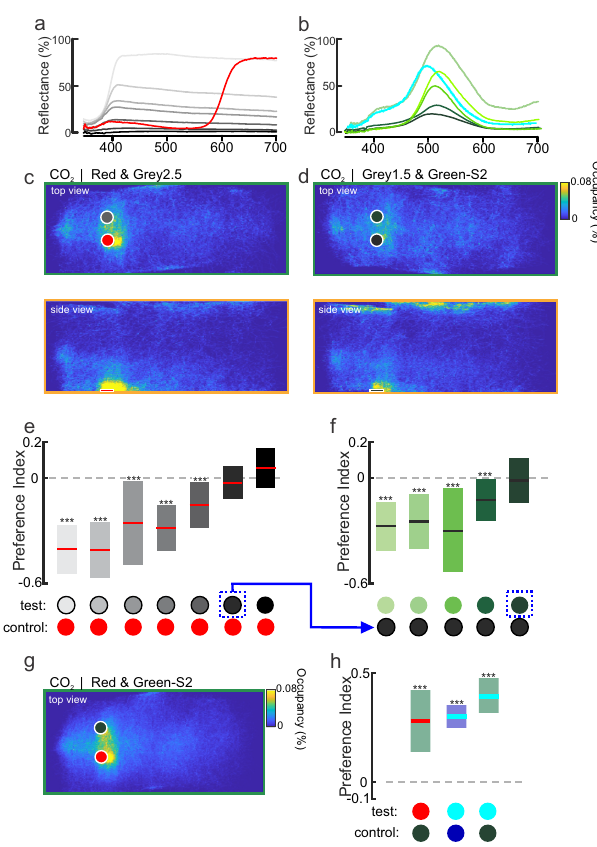
Fig. 6 The role of dominant wavelength vs. contrast in mosquito visual attraction. a Spectral re fl ectance of 660 nm (R-Hue), black, and gray objects used in the experiments: Gray 9.5, 6.5, 4.5, 4.0, 2.5, and 1.5, with Weber contrast values of − 0.17, − 0.30, − 0.05, − 0.10, − 0.20, − 0.24, − 0.27, and − 0.28, respectively. b Spectral re fl ectance of 496 nm and 510 nm objects used in the experiments: Gw-T1, Gw-T3, Gc-T1, Gc-Hue, G-S1, and G-S2, with Weber contrast values of − 0.18, − 0.11, − 0.17, − 0.20, − 0.25, and − 0.27, respectively. c , d Occupancy maps showing the distribution of female mosquitoes in the wind tunnel (top and side views) during CO 2 delivery in presence of the 660 nm (R-Hue) and Grey2.5 objects ( c ), or 510 nm (G-S2) and Grey1.5 objects ( d ); both the 510 nm and Grey1.5 objects have the same levels of contrast with the background (Weber Contrasts of − 0.27). e Mean preference indices for the 660 nm vs. gray objects with different levels of contrast with the background. The Grey1.5 object (Weber Contrast value of − 0.28) was not signi fi cantly different from 0 (one-sample two-tailed t -test: P = 0.07) and was subsequently used in experiments in ( f ) (blue arrow). f The Grey1.5 object was signi fi cantly more attractive than most of the 510 nm objects (one-sample two-tailed t -test: P < 0.001, ***), although the darkest 510 nm object (G-S2; Weber Contrast = − 0.27) was not signi fi cantly different from 0 (one-sample two-tailed t -test: P = 0.66)) ( n = 10,098 – 15,578 trajectories for each tested object). g As in ( c ), occupancy maps showing the distribution of trajectories around the 660 nm and dark 510 nm objects. h Mean preference indices for 660 nm vs. dark 510 nm objects, and 496 nm vs. dark 452 nm or dark 510 nm objects. Mosquitoes signi fi cantly preferred the 660 nm and 496 nm objects over the dark chromatic objects (510 nm and 452 nm)(one- sample two-tailed t -test: P < 0.0001). For ( e , f and h ), boxplots area the mean (line) with 95% con fi dence interval (shaded area), and asterisks denote P < 0.001 (one-sample t -test) ( n = 7191 – 27,717 mosquito trajectories for each tested